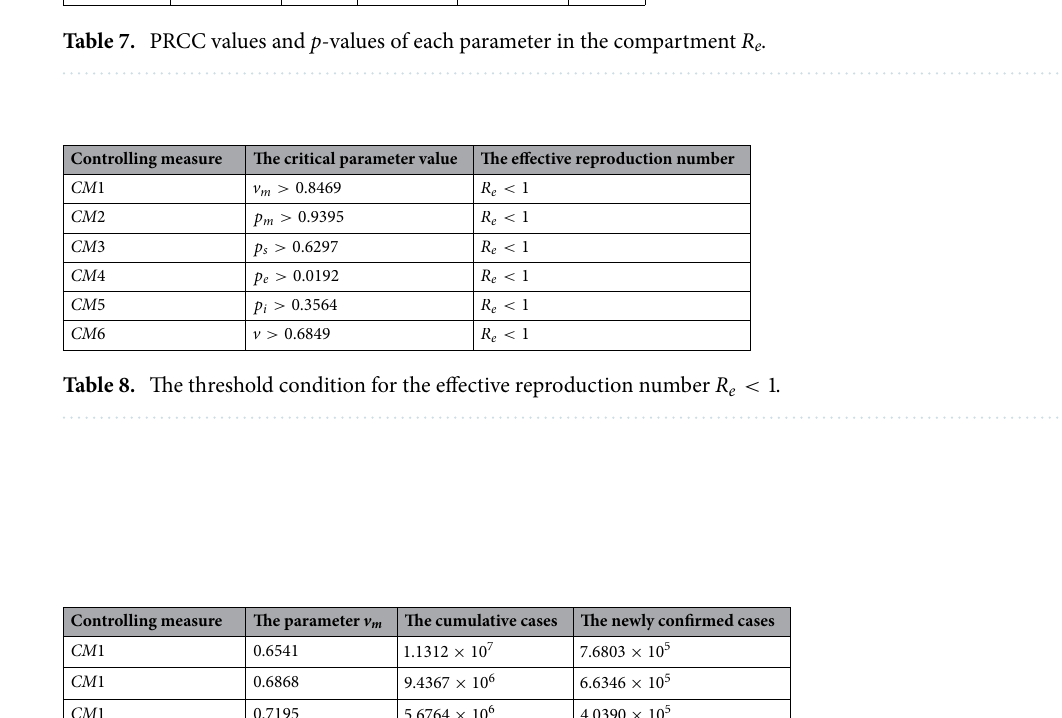
Table 7. PRCC values and p -values of each parameter in the compartment R e .